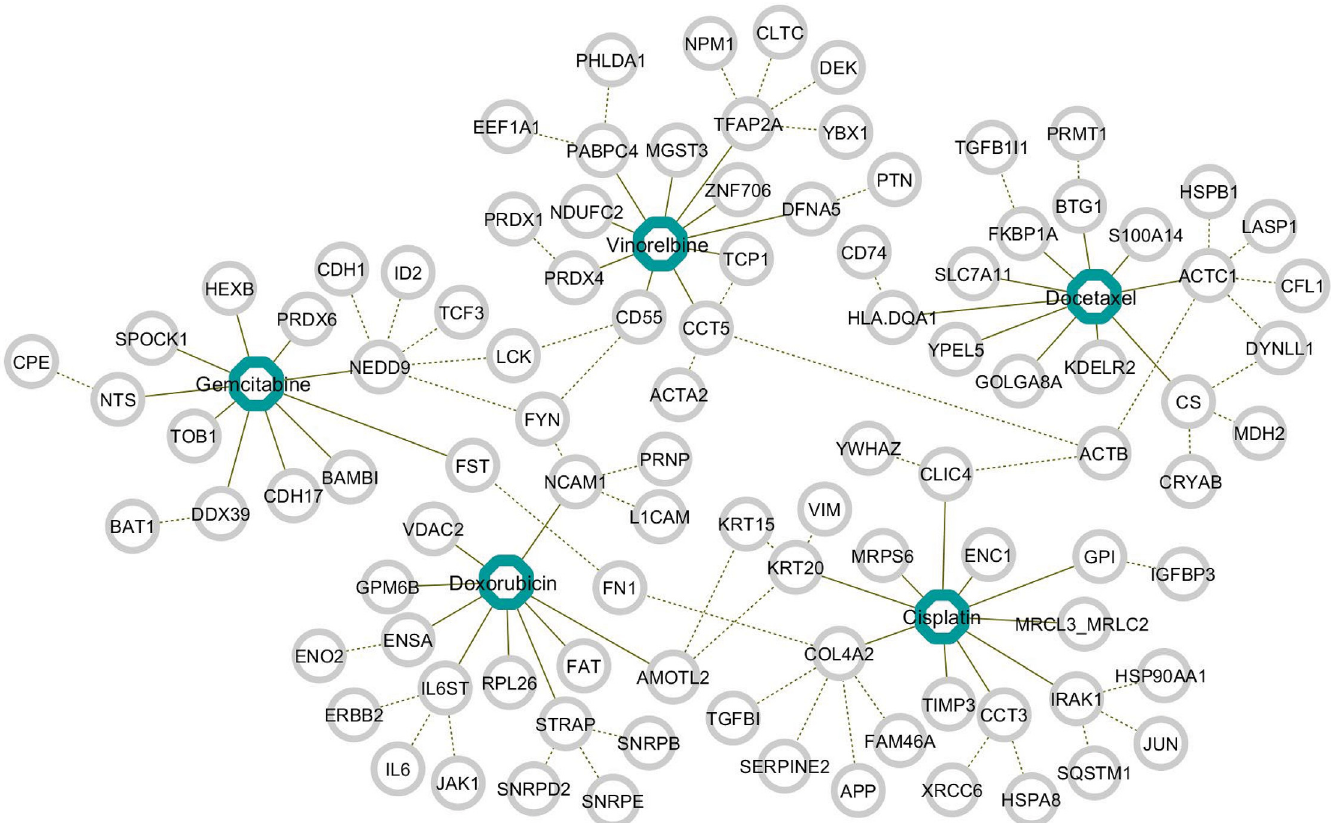
Fig 3. Network for selected driver genes and genes having PPI with identified driver